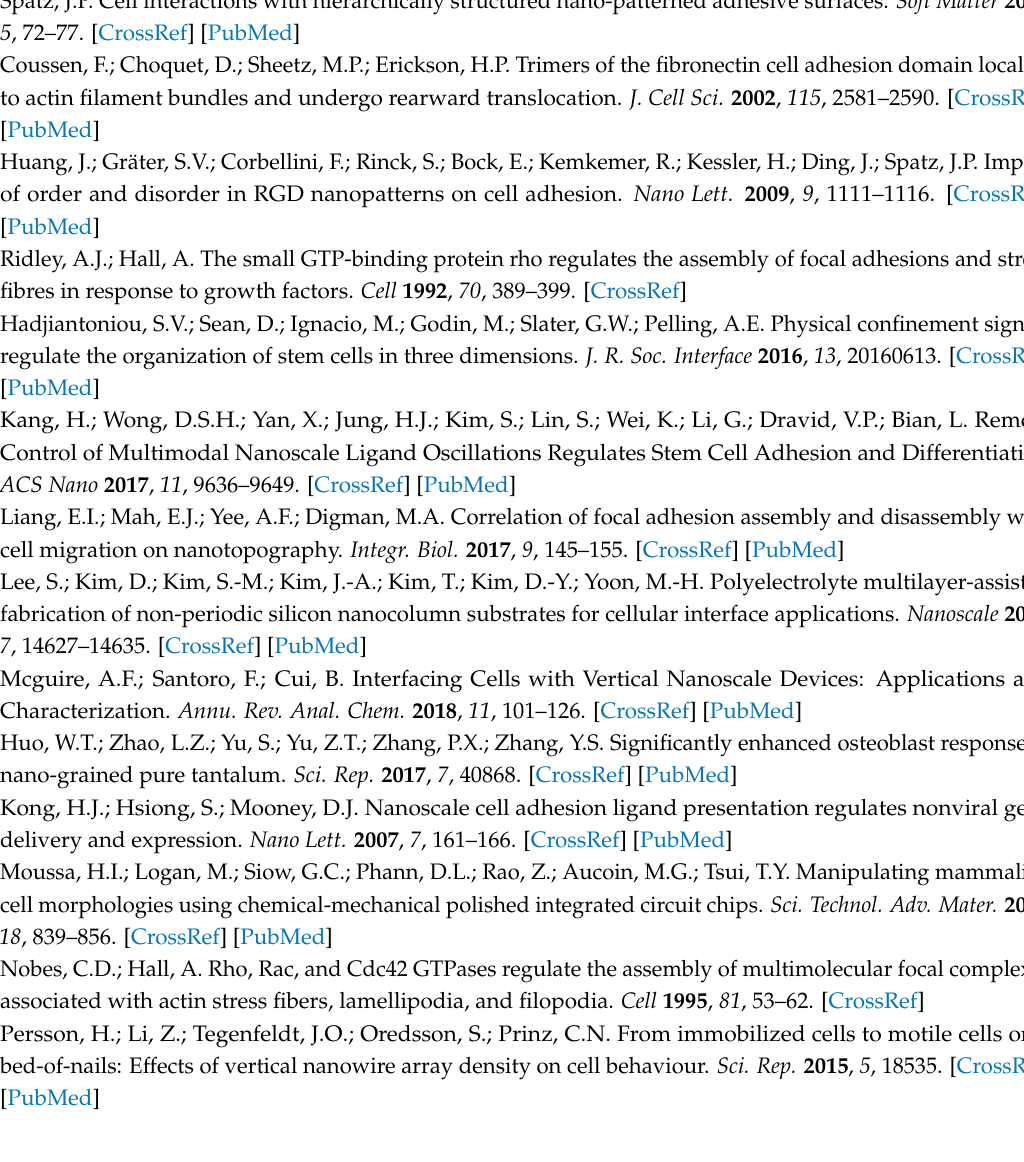
s1. Figure S1: SEM micrograph of cross-sectioned specimens, Figure S2: Cell on 0.21 µ m comb structure incubated for 0.5 hours (1), Figure S3: Cell on 0.21 µ m comb structure incubated for 0.5 hours (2), Figure S4: Cell on 0.21 µ m comb structure incubated for 0.5 hours (3), Figure S5: Cell on 0.26 µ m comb structure incubated for 0.5 hours (1), Figure S6: Cell on 0.26 µ m comb structure incubated for 0.5 hours (2), Figure S7: Long single-stranded filopodia on 0.21 µ m comb